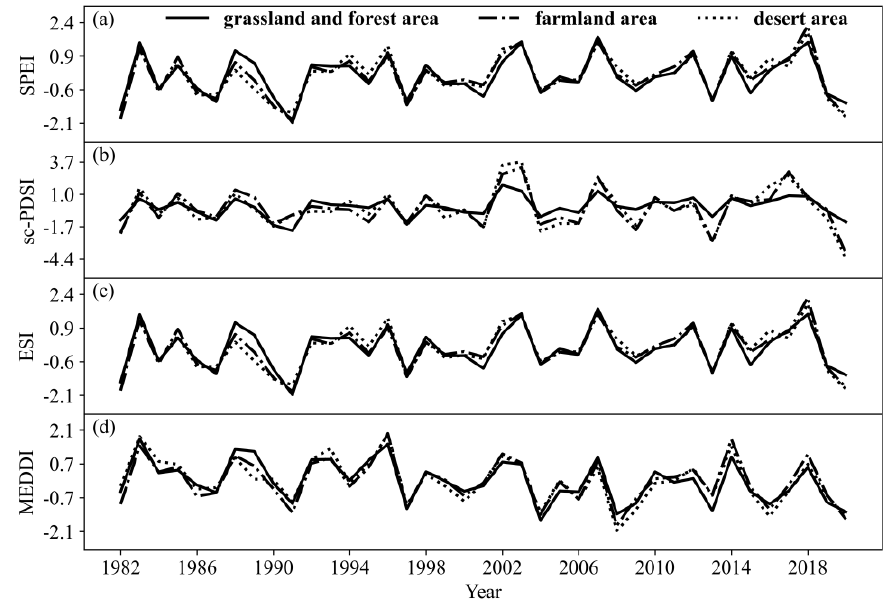
Figure A1. Temporal changes ( a ) SPEI, ( b ) sc-PDSI, ( c ) ESI and ( d ) MEDDI in the grassland and forest area, farmland area and desert area over 1982 − 2020. Table A1. Temporal trends of SPEI, sc-PDSI, ESI and MEDDI in the grassland and forest area, farm- land area and desert area, over 1982 − 2020.